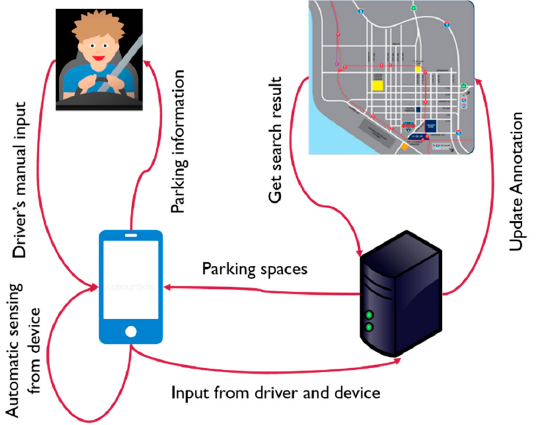
Figure 2. Reference model of smartphone-based parking systems.